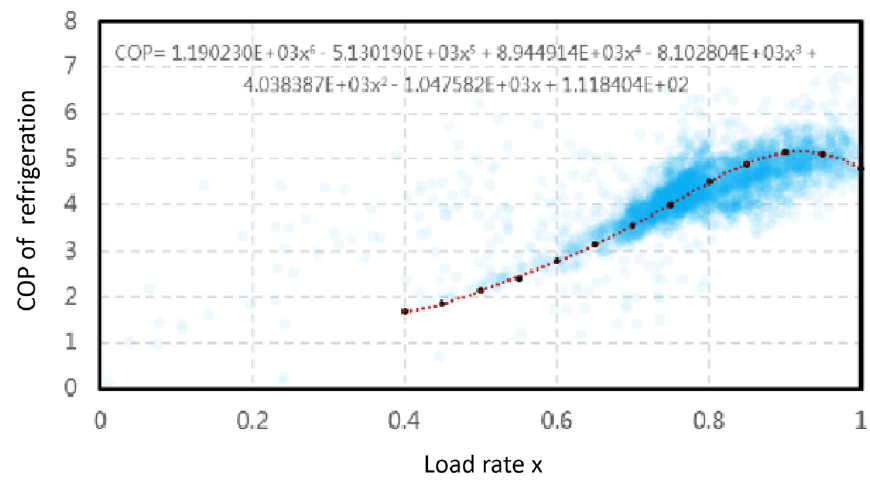
Fig. 27 Energy efficiency model of GSHP unit COP variation with load rate